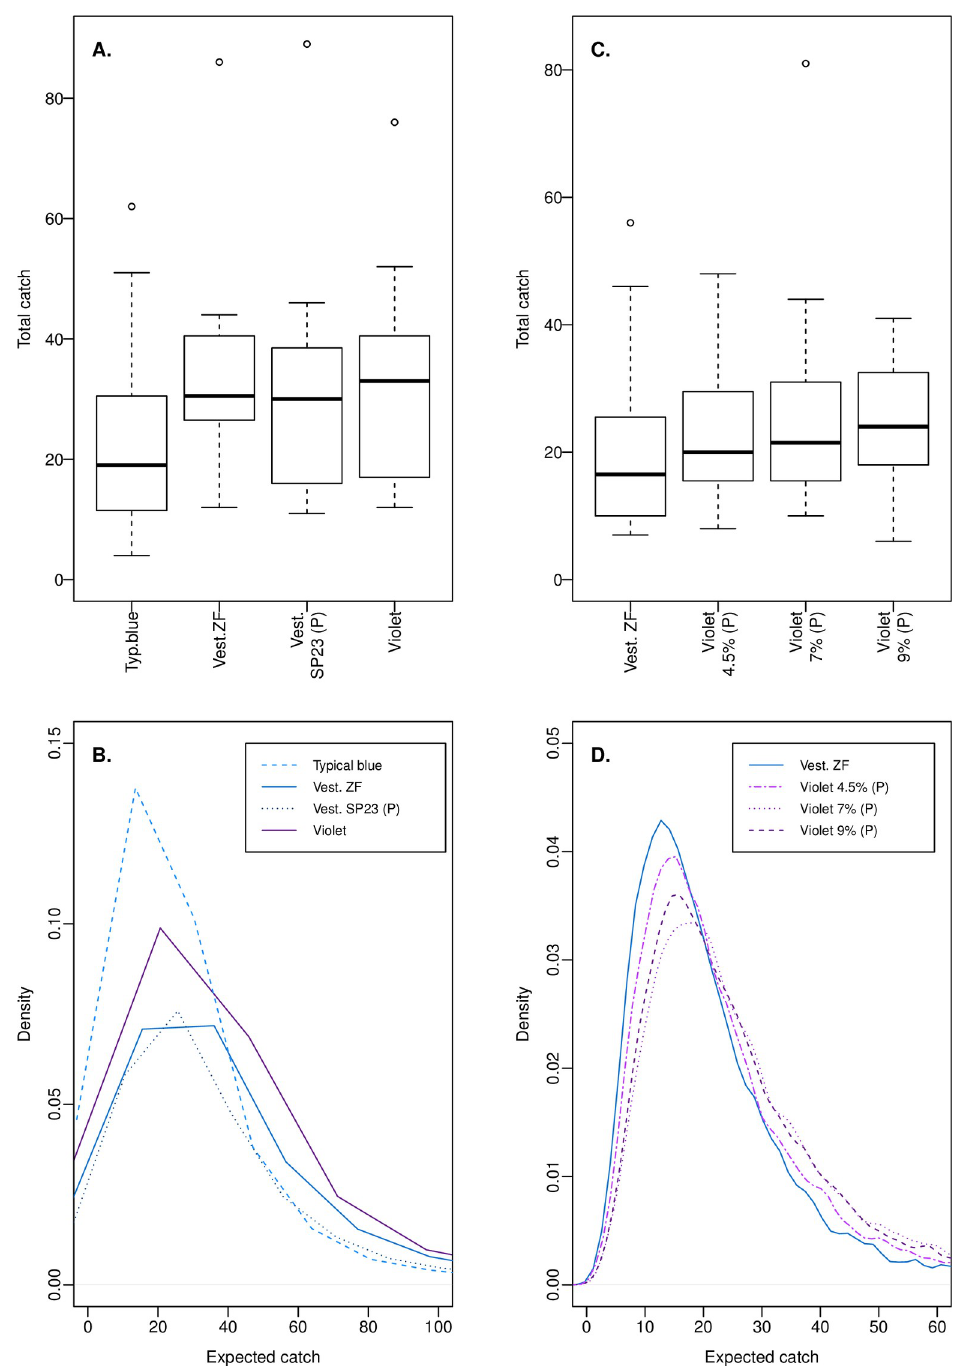
Fig 2. Recorded and posterior predicted G . f . fuscipes catches based on experiments in Kenya. (A) The distribution of recorded tsetse catches for the four target fabrics tested in experiment 1. (B) Probability density functions for 10,000 expected catches for the targets tested in experiment 1, computed using the posterior probabilities of model coefficients from a Bayesian model of the data in panel A. (C) The distribution of recorded tsetse catches across the four target fabrics tested in experiment 2. (D) Probability density functions for 10,000 expected catches for each target tested in experiment 2, computed using the posterior probabilities of model coefficients from a Bayesian model of the data in panel C. Boxes in panels A and C indicate the 25 th , 50 th , and 75 th percentiles; whiskers extend to the most extreme value, or to 1.5 � IQR with more extreme values plotted as points. Sample sizes are 16 catch observations per target. In panels B and D, note that sampling variation across new intercepts for day, site, and replicate